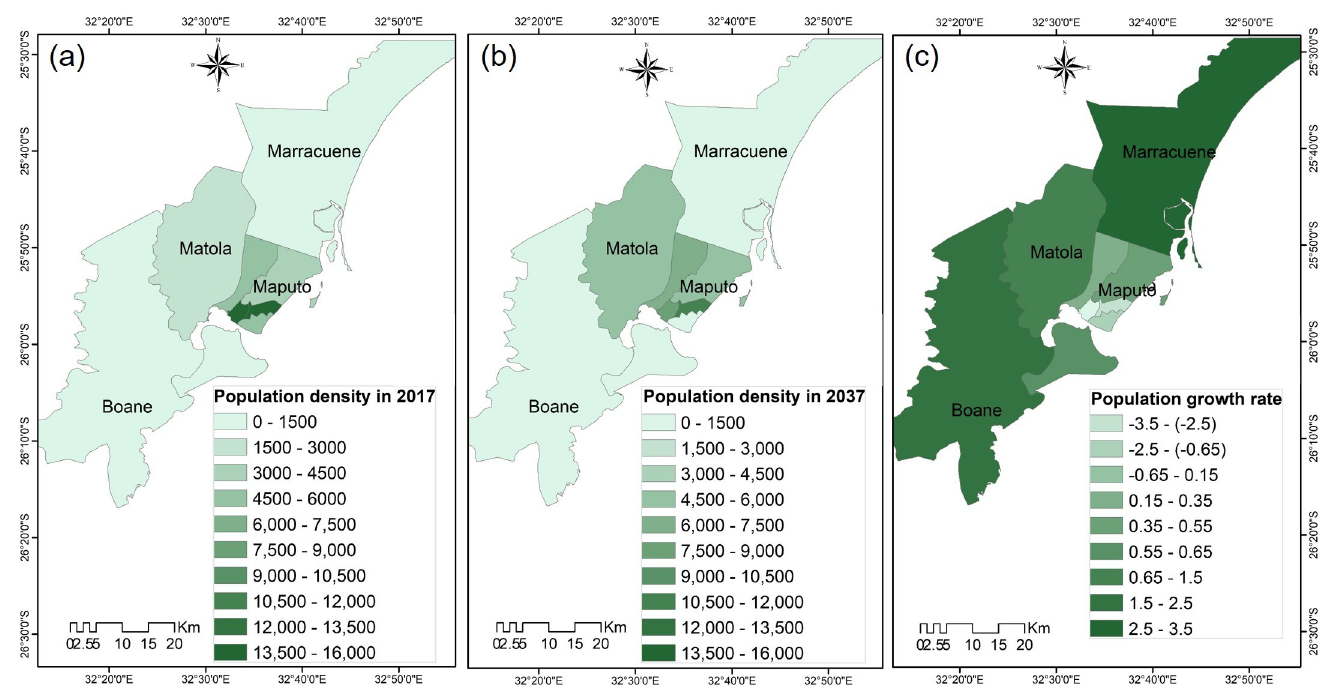
Fig 6. Population projection scenarios. (a) population density in 2017 (inhabitants/Km 2 ); (b) population density in 2037 (inhabitants/Km 2 ); (c) population growth rate average (%). Maps were edited from the Landsat [45] and USGS EROS [46].